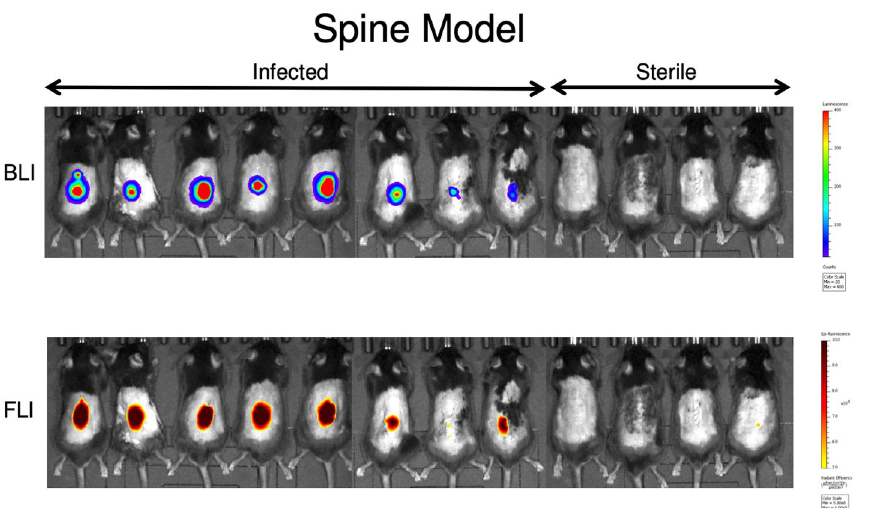
Figure 6. Bioluminescence and fluorescence imaging of mice with a spinal implant infection 72 h post 1D9- 680 probe injection. At 72 h PI of the 1D9-680 probe, co-localization of the probe in 8 mice with infected implants is evidenced by bioluminescence and fluorescence imaging as described for Fig. 3. As expected, neither bioluminescence nor fluorescence are detectable in the 4 control mice with sterile spinal